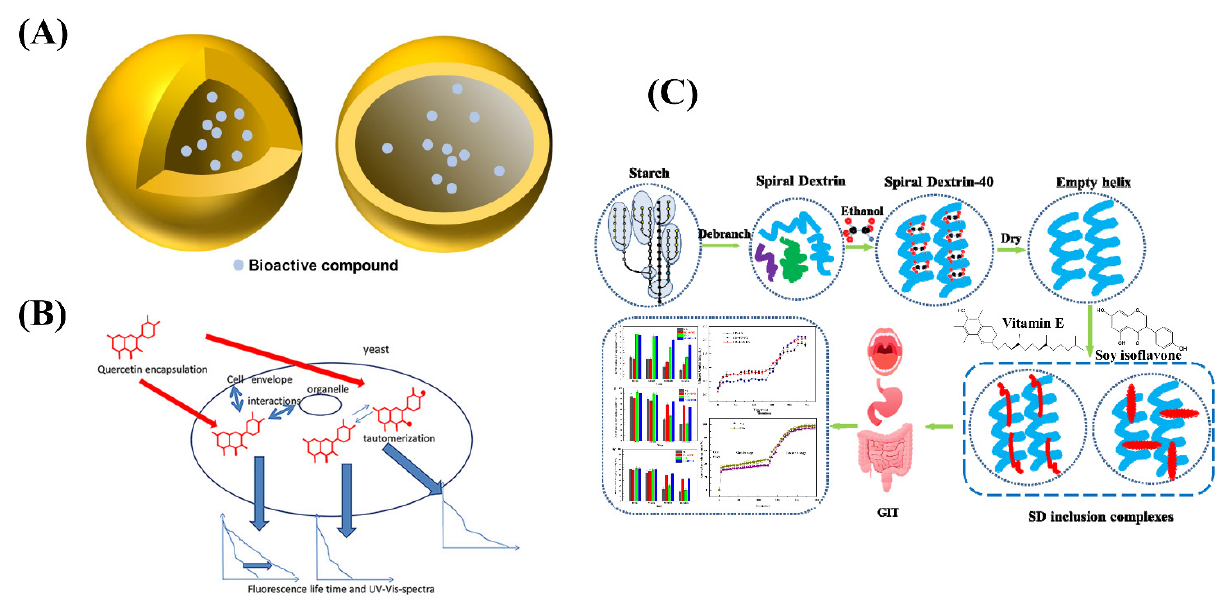
Figure 4. ( A ) The structure of nano-capsule. ( B ) Schematic illustration of quercetin encapsulated in yeast microcapsules. ( C ) Schematic diagram of nanocapsule of vitamin E and soy isoflavone using spiral dextrin.